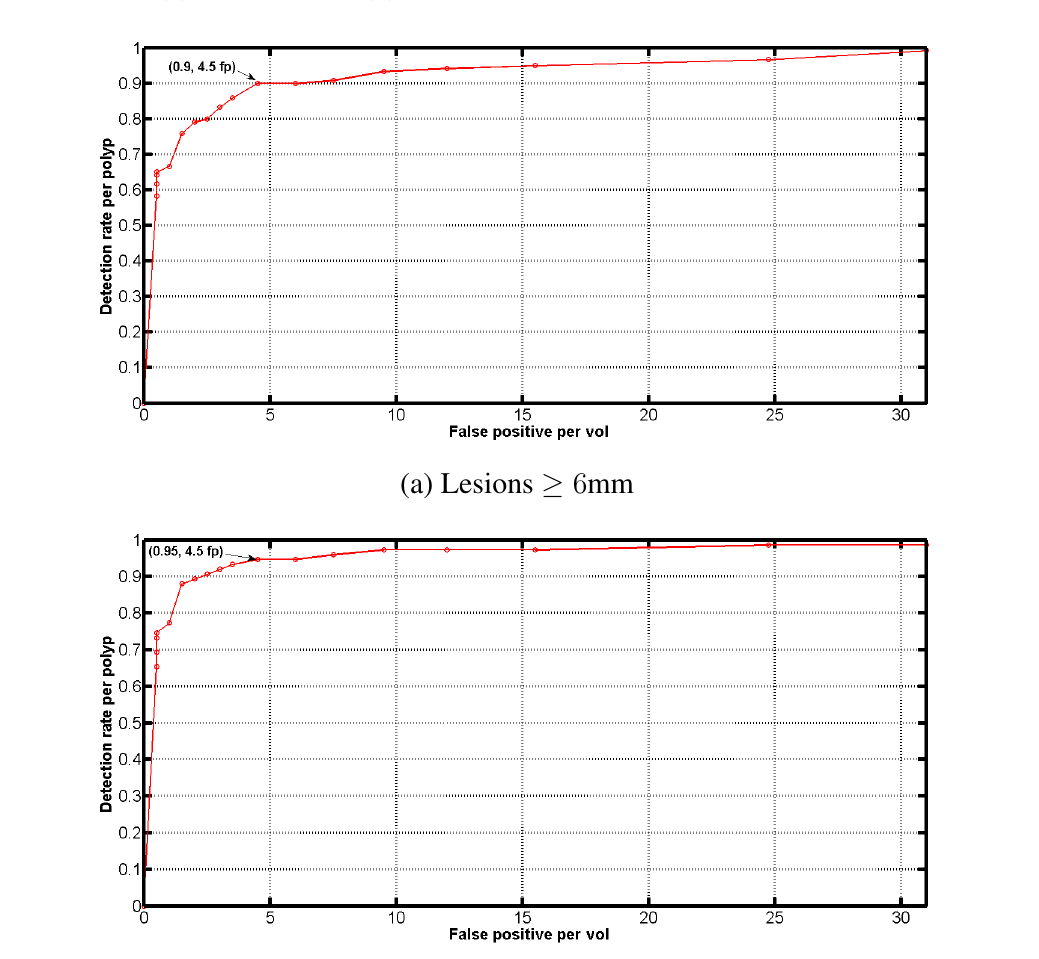
Figure 8. FROC curves demonstrating CAD performance on independent test data for lesions > 6 mm (a) and > 10 mm